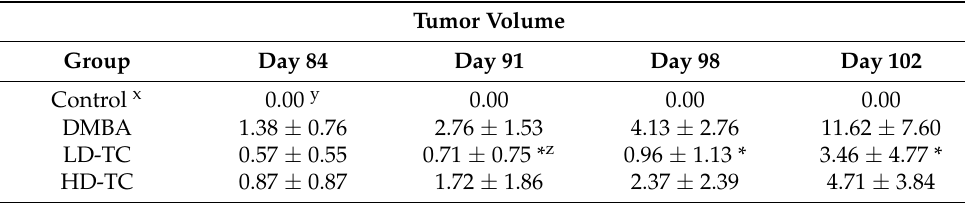
Table 3. Effects of theacrine on tumor volume.